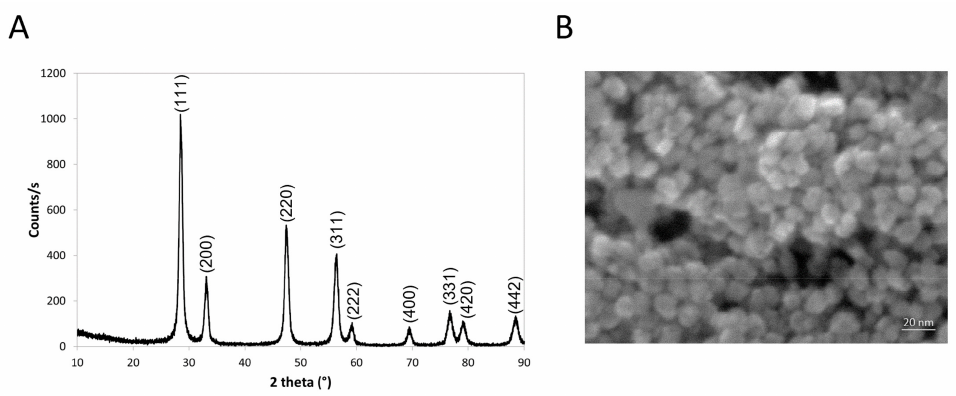
Figure 1. Nanoceria physicochemical characterization. ( A ) XRD diffraction patterns and Miller indexes of nanoceria. ( B ) Scanning electron microscopy (SEM) image of nanoceria. The scale bar corresponds to 20